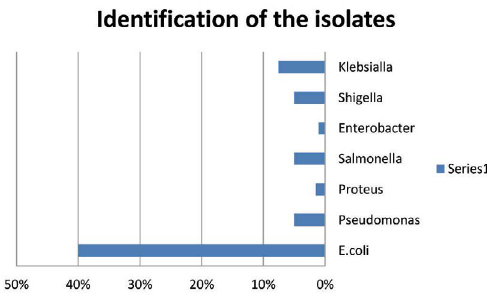
Fig 2. Percentage of isolates used in the study.